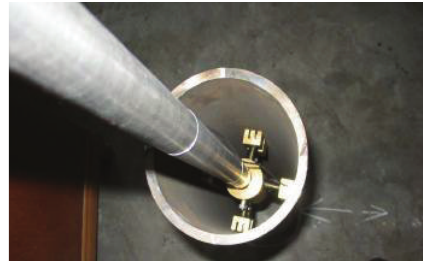
Figure 10: Sketch of scan test.